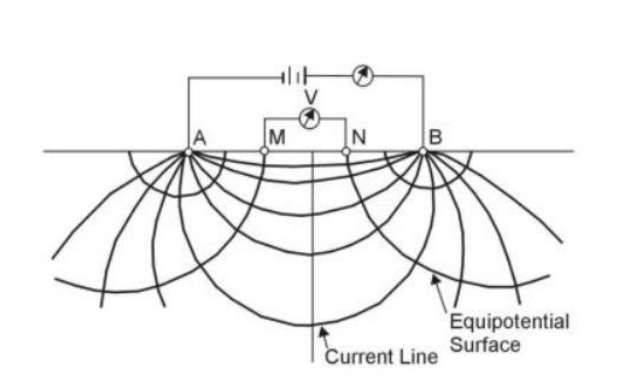
Figure 9. The disposition of electrodes A, M, N, B, current and equipotential lines (draw by U.S. Environmental Protection